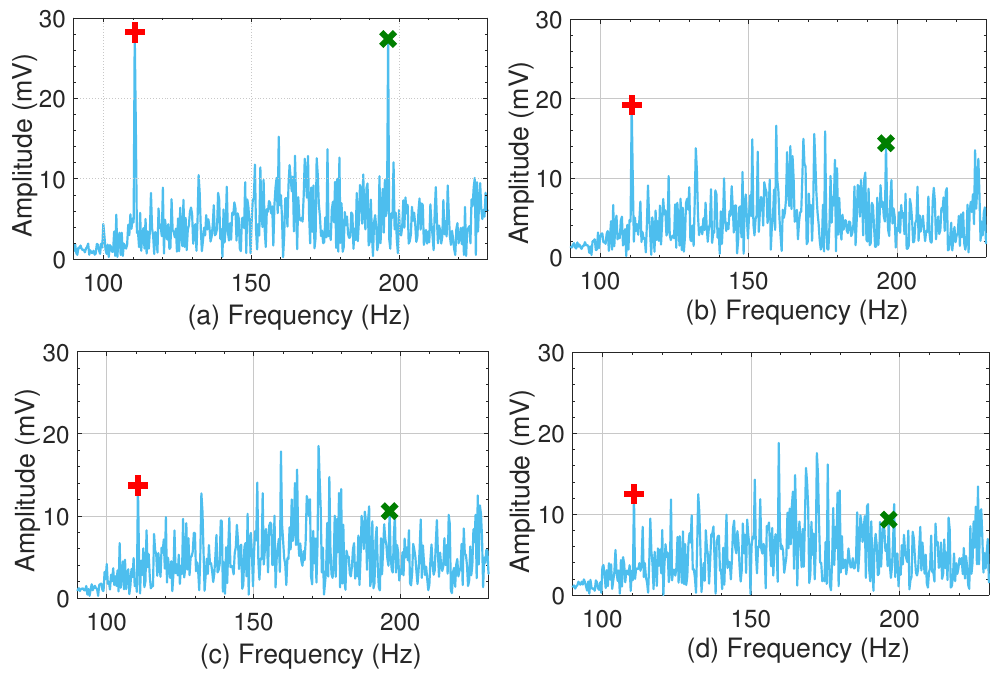
Figure 10. Frequency spectra evaluated by the developed module in case of 2 tones added to the environmental noise, for ( a ) A dB = 40 dB, ( b ) A dB = 35 dB, ( c ) A dB = 30 dB, and ( d ) A dB = 25 dB. The plus markers refer to the BPFO tone and the cross ones to the BPFI